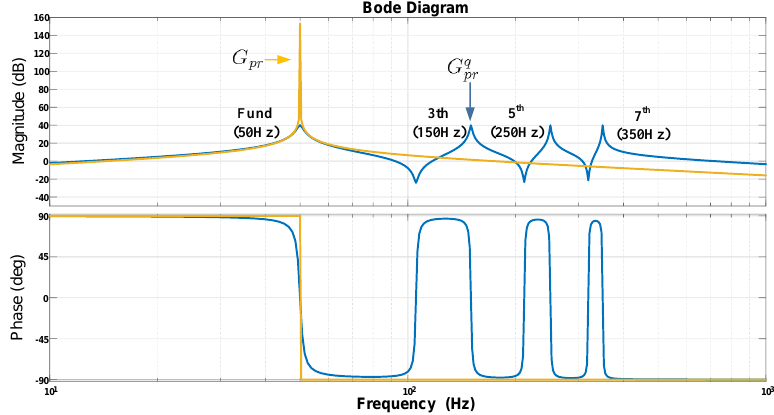
Figure 6. Bode diagram of the controller of series